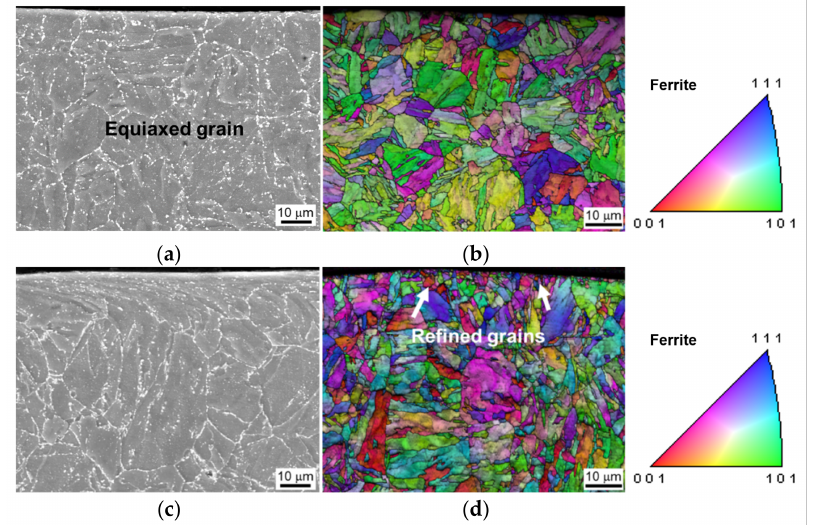
Figure 2. Surface microstructure of the specimens before steam oxidation: ( a , b ) SEM and EBSD IPF with orientation map of the untreated specimen, ( c , d ) SEM and EBSD IPF with orientation map of the shot peened specimen.